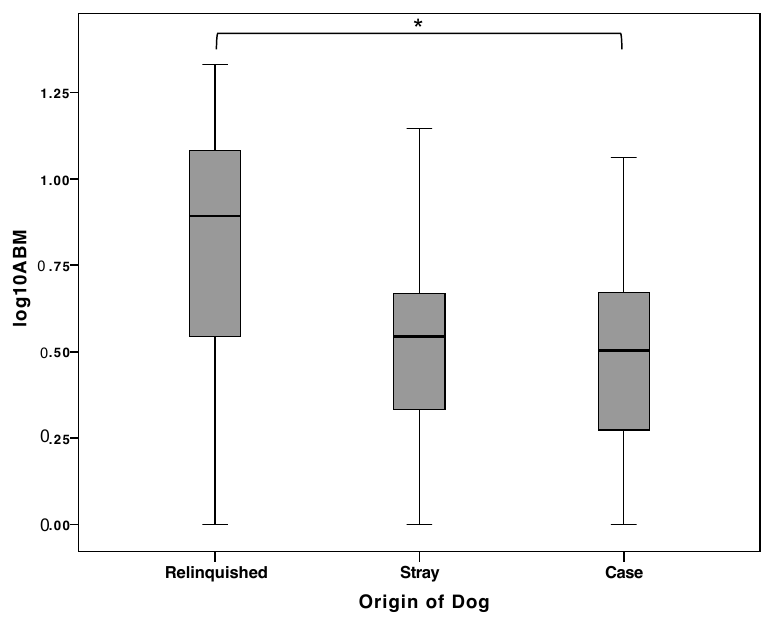
Figure 1. Boxplot showing the distribution (median and interquartile ranges) of time spent awake but motionless (ABM; logarithmically transformed) between dogs that were relinquished by their owners ( n = 21), found as strays ( n = 7) or seized as part of animal welfare legal cases ( n = 14). ANOVA with Tukey post-hoc: F = 8.09, * p = 0.032.